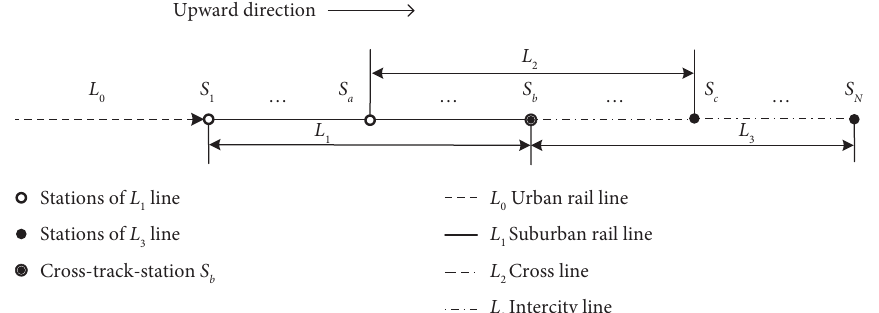
Figure 1: Sketch map of train running